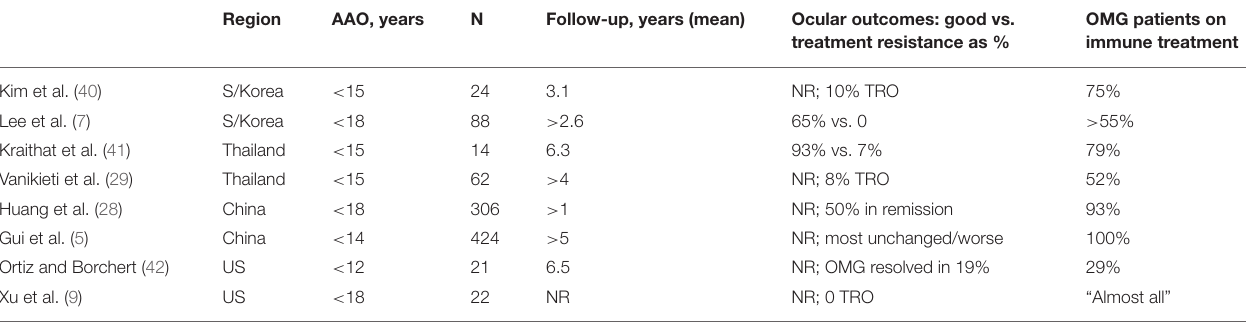
TABLE 2 | Outcomes of extraocular muscles in juveniles with MG by region. Region AAO, years N Follow-up, years (mean) Ocular outcomes: good vs.